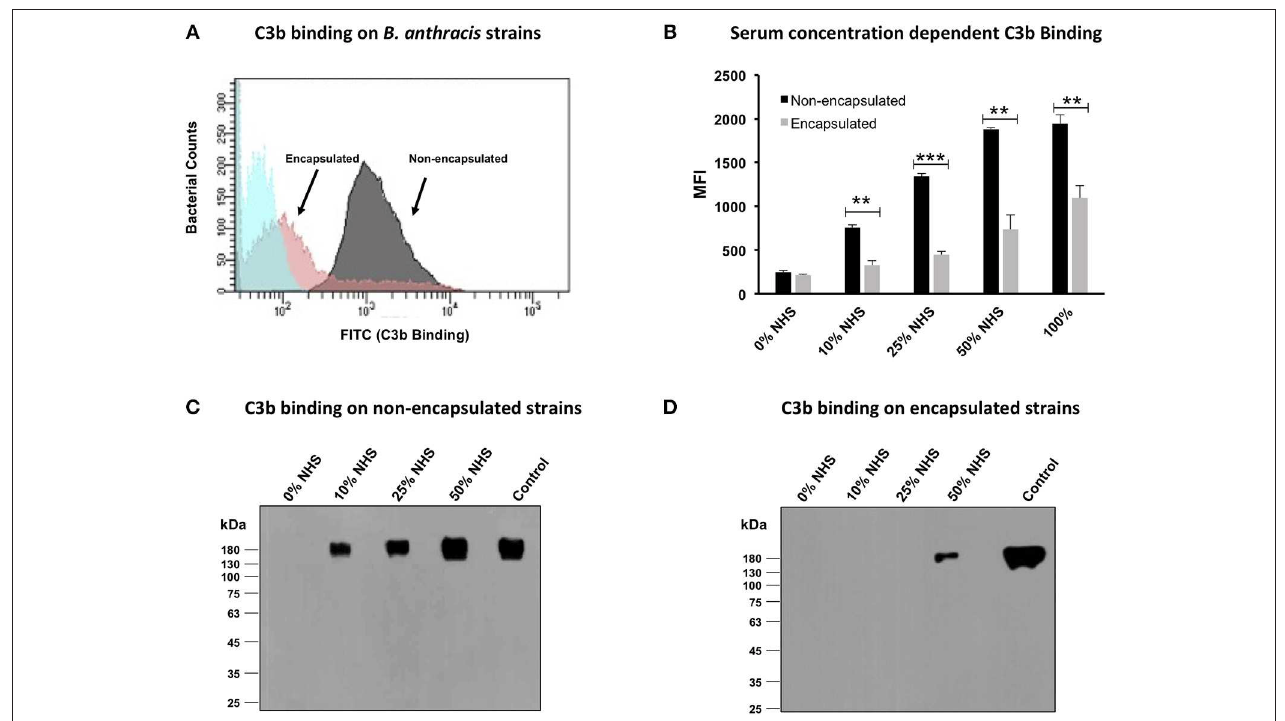
FIGURE 2 | C3b deposition on encapsulated and non-encapsulated strains of Bacillus anthracis. (A) Flow cytometry histogram of C3b deposition on encapsulated and non-encapsulated B. anthracis strains incubated in 10% human serum. Gray and pink shading indicates non-encapsulated and encapsulated bacteria, respectively. Blue shading indicates bacteria incubated in phosphate-buffered saline (PBS) alone. (B) Mean fluorescence index (MFI) of serum concentration-dependent C3b deposition on encapsulated and non-encapsulated bacteria. Black and gray bars represent non-encapsulated and encapsulated strains, respectively. The scatter plots for the corresponding histograms are represented in Figure S3 . (C,D) Immunoblot assays to detect serum concentration-dependent C3b deposition on non-encapsulated (C) and encapsulated strains (D) ; 1% normal human serum was used as positive control. Each data point represents the mean of three independent experiments. Error bars represent standard error of the mean. Statistical significance is highlighted by the following denotations: ** for P -value < 0.01, and *** for P -value <